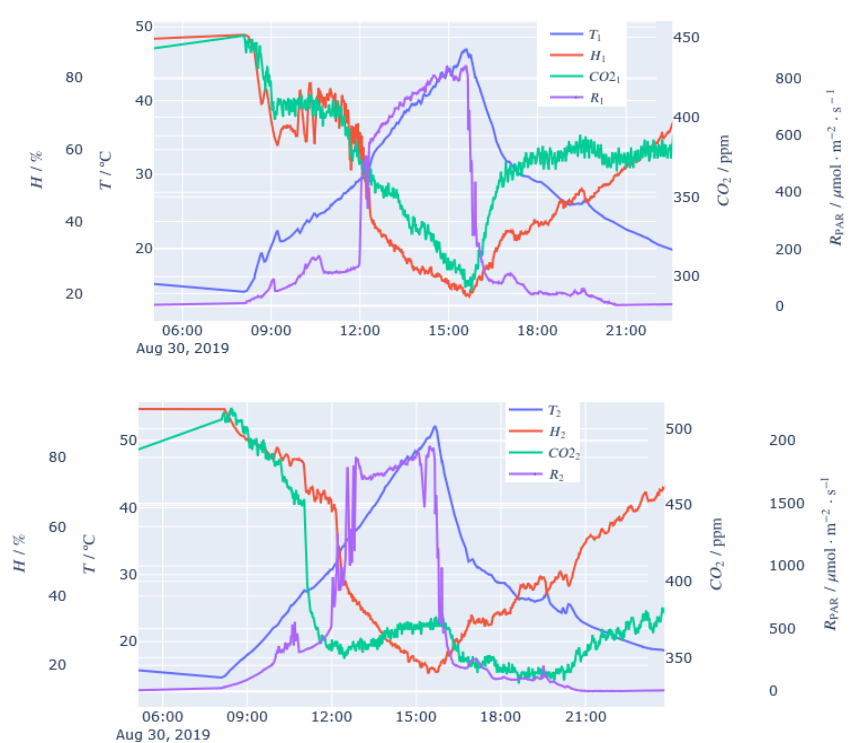
Figure 12. Relationship between temperature, relative humidity, CO 2 concentration and PAR radi- ation before planting (1: PV glasses, 2: conventional glasses). tion before planting (1: PV glasses, 2: conventional